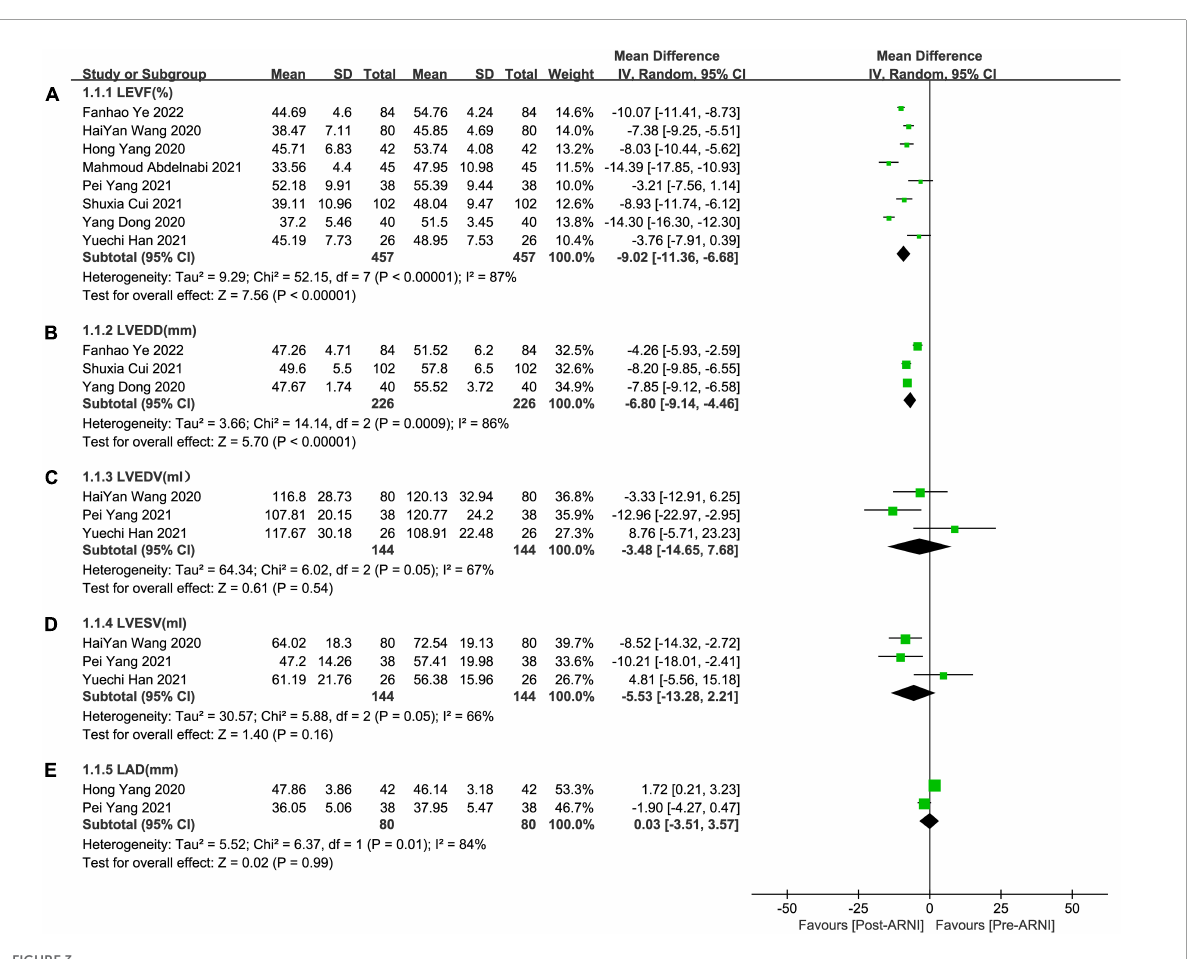
FIGURE3 Forest plots for effects of ARNI on LVEF and other CRR indices of myocardial infarction patients. (A) The forest plots of the left ventricular ejection fraction, (B) the forest plots of the left ventricular end-diastolic diameter, (C) the forest plots of the left ventricular end-diastolic volume, (D) the forest plots of the left ventricular end-systolic volume, and (E) the forest plots of the left atrial